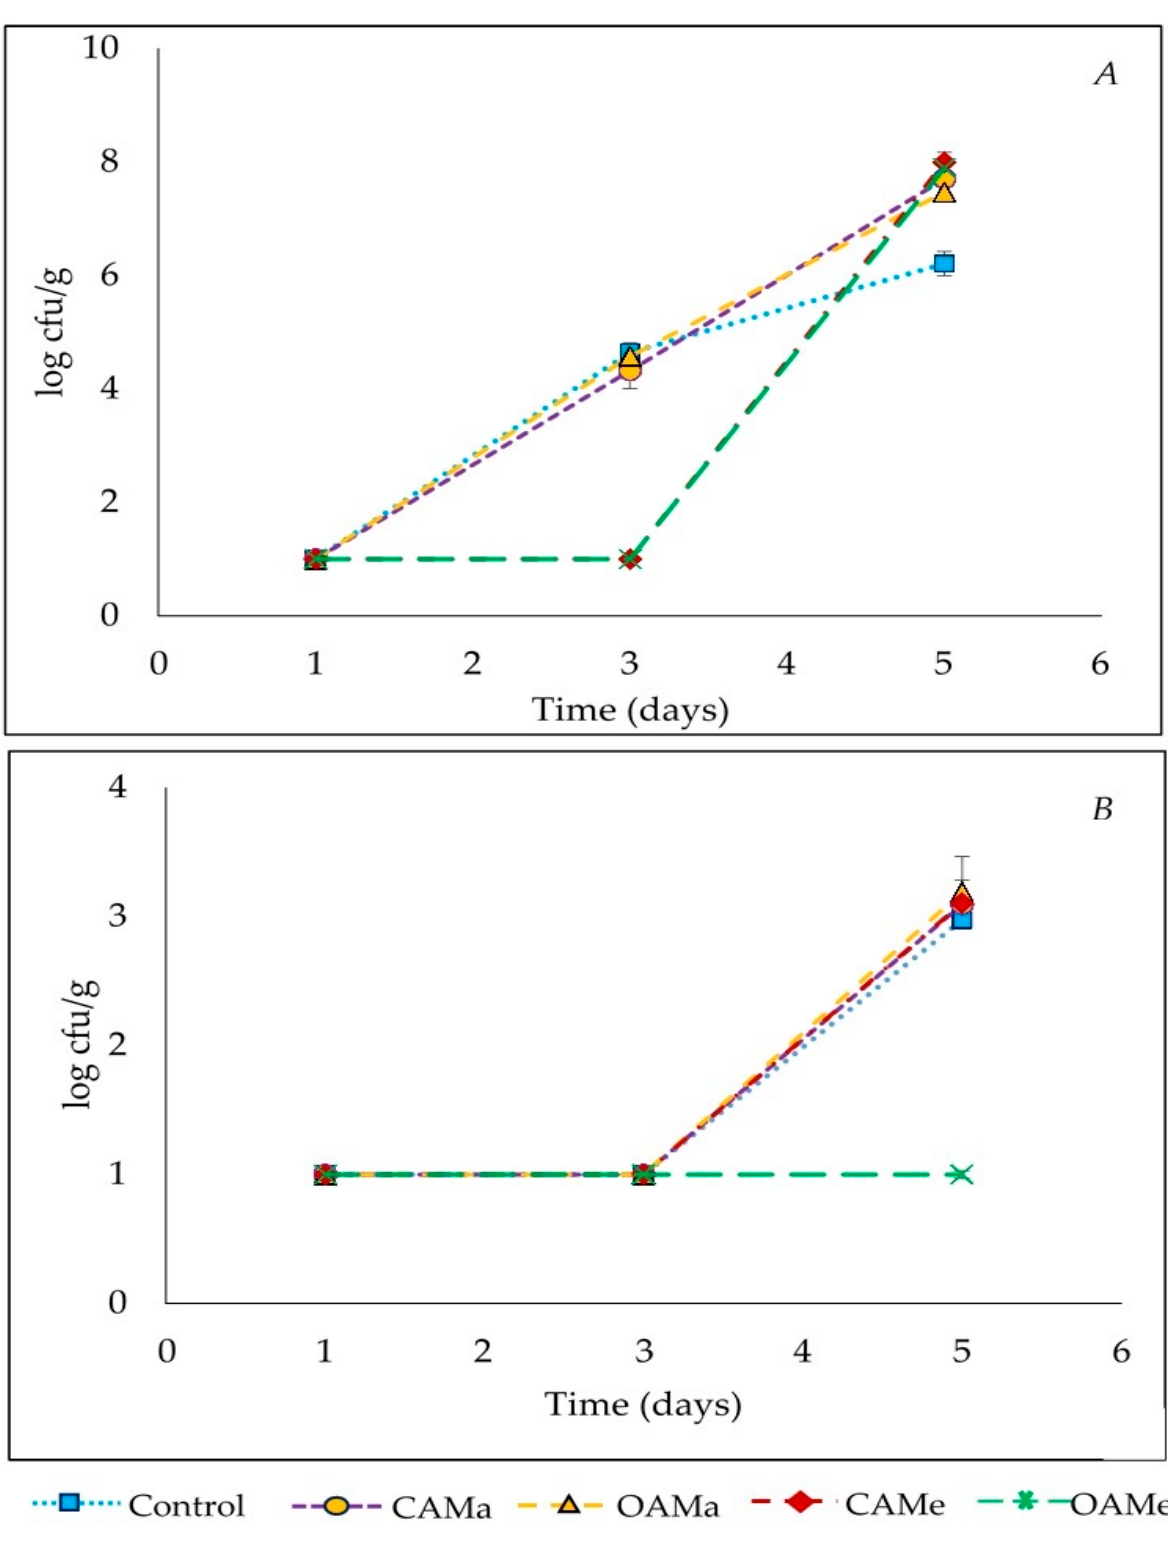
Figure 6. ( A ) Total aerobic mesophiles bacteria [cfu/g] and ( B ) mold and yeast [cfu/g]. Results are the mean ± standard deviation. Different letters (a, b, c) in the same line indicate significant differences among days for each sample ( p < 0.05).